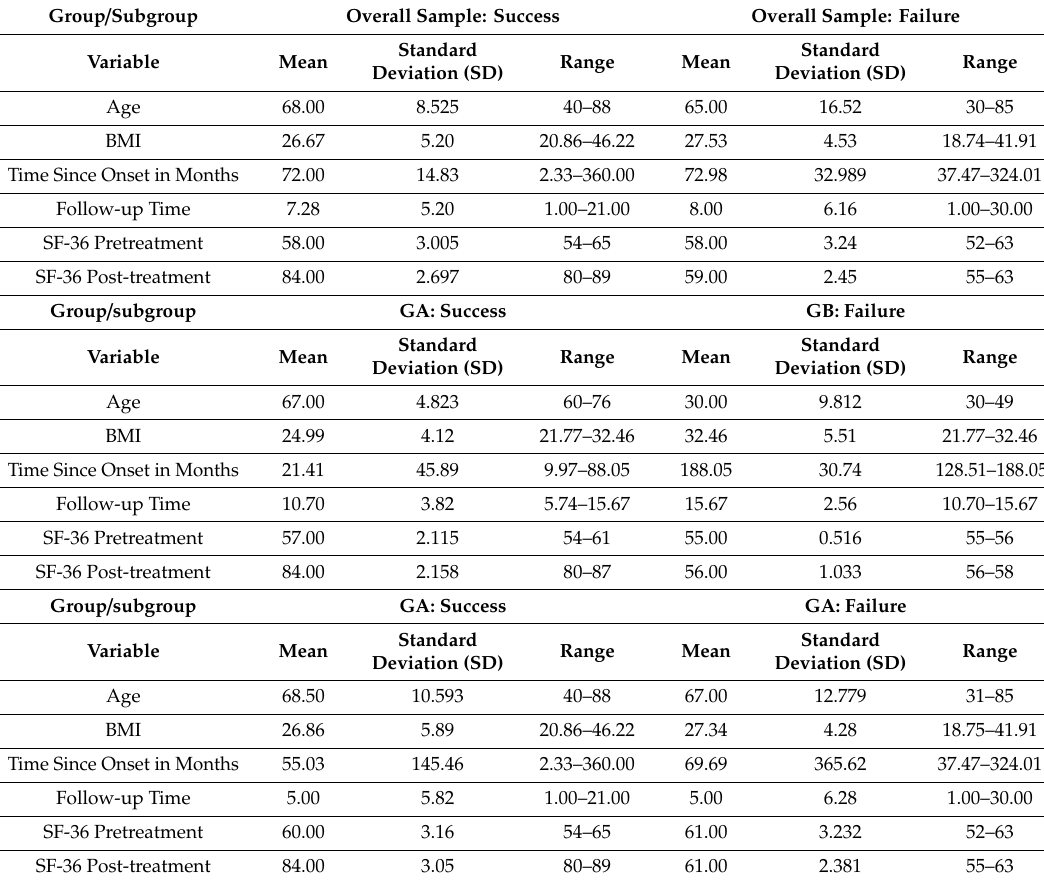
Table 1. Age, BMI, time since onset of cystocele, follow-up time, SF-36 before and after treatment.